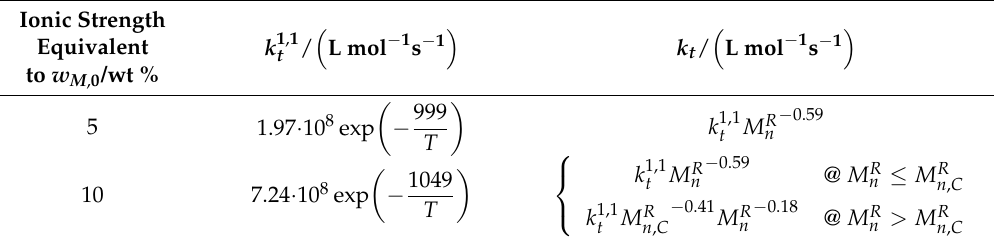
is equal to n , C